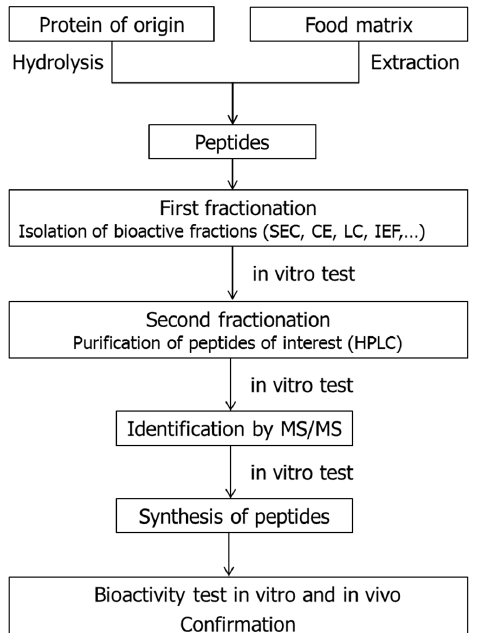
Figure 3. Scheme of the traditional empirical procedure for the identification and confirmation of bioactive peptides from food matrices. SEC: size-exclusion chromatography; CE: capillary electrophoresis; LC: liquid chromatography; IEF: isolectric focusing; HPLC: high performance liquid chromatography; MS/MS: mass spectrometry in tandem.